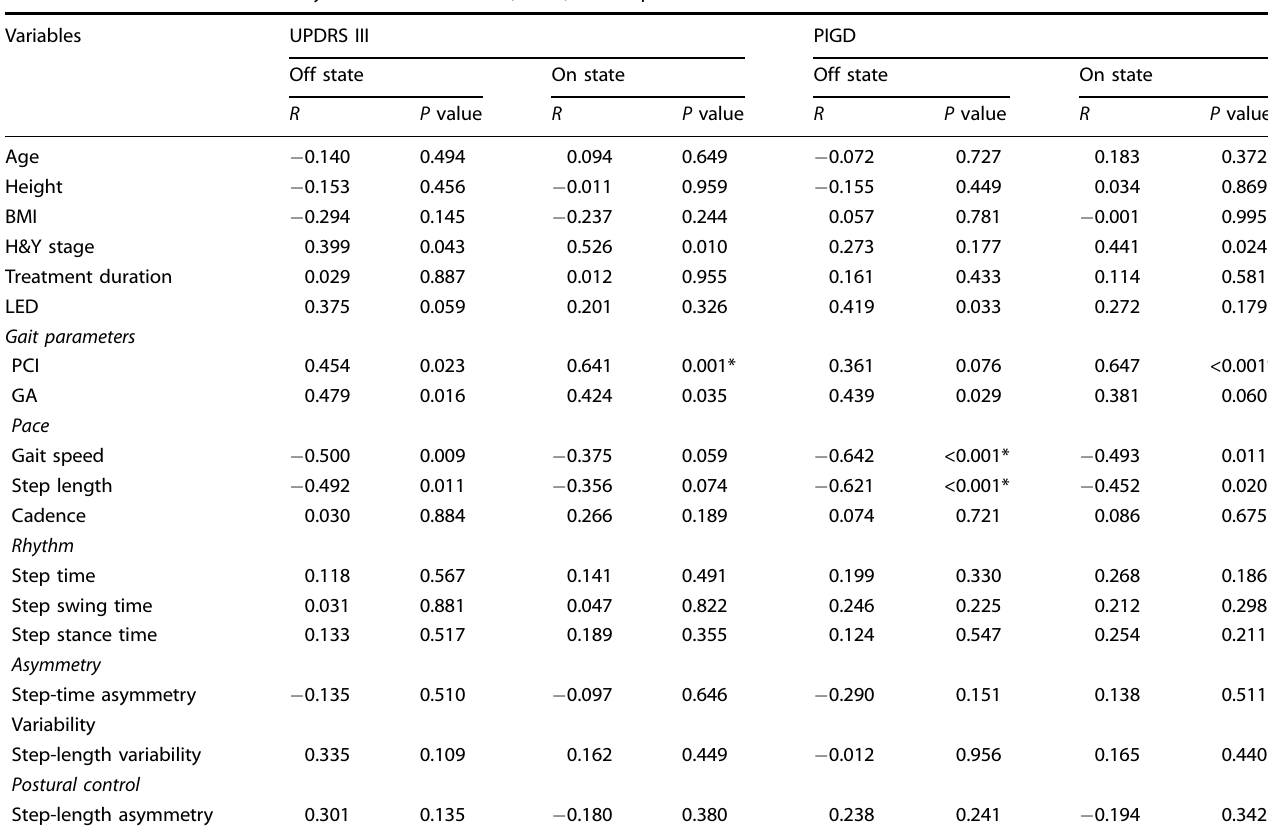
Table 2. Results of correlation analysis between UPDRS III, PIGD, and all